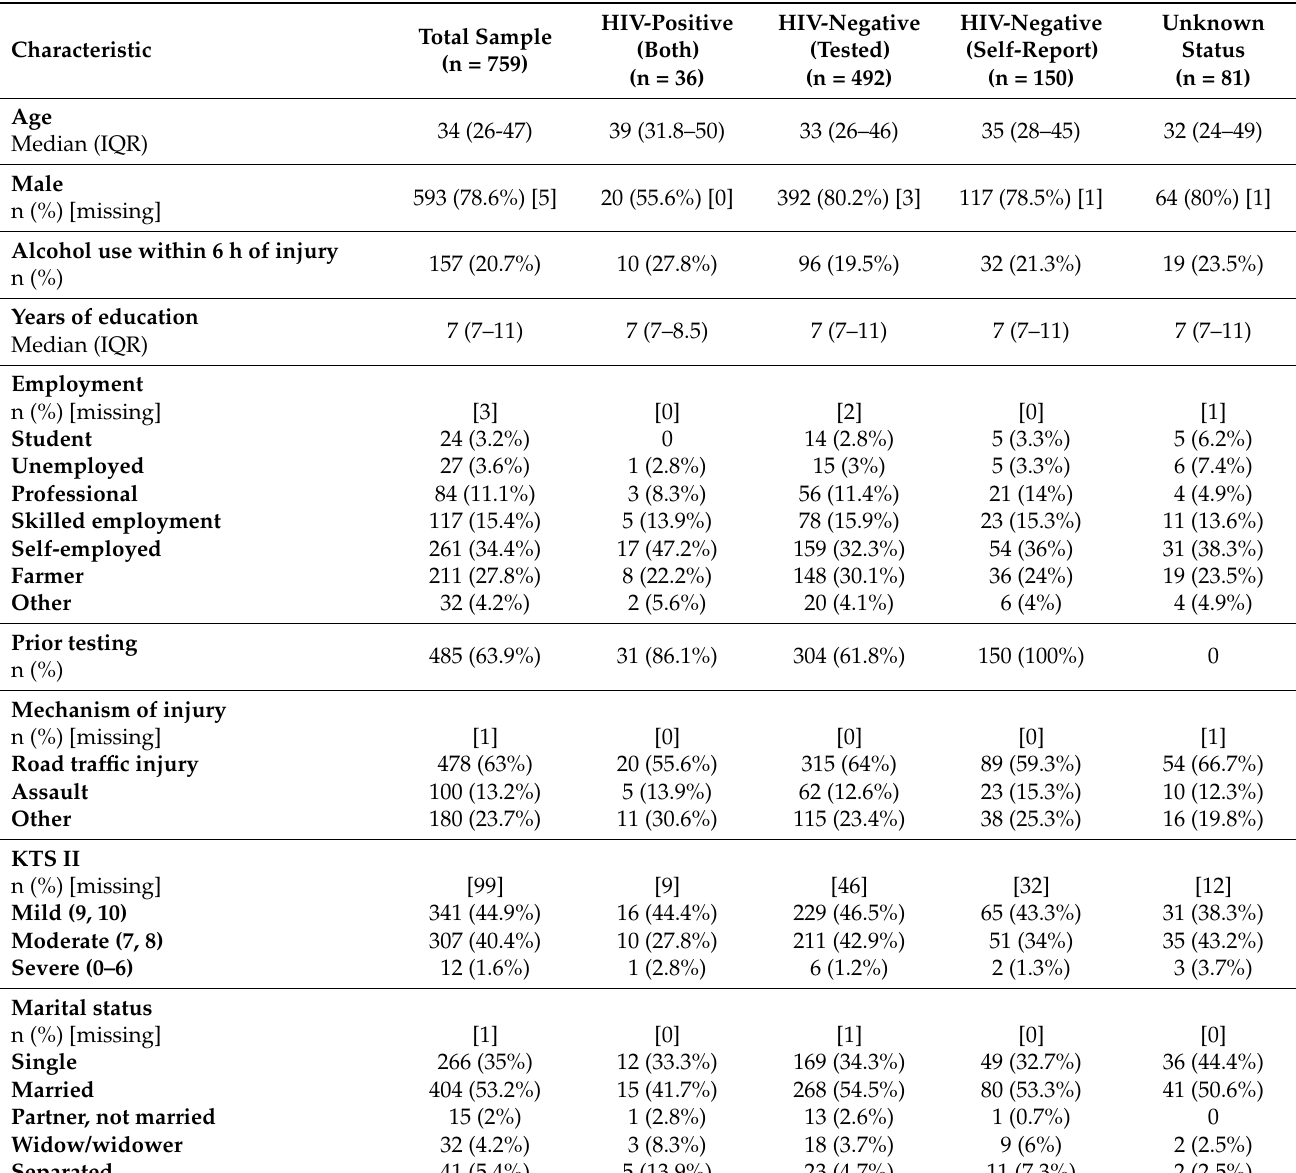
Table 1. ED injury patient population demographics stratified by HIV status (‘n’ indicates number of